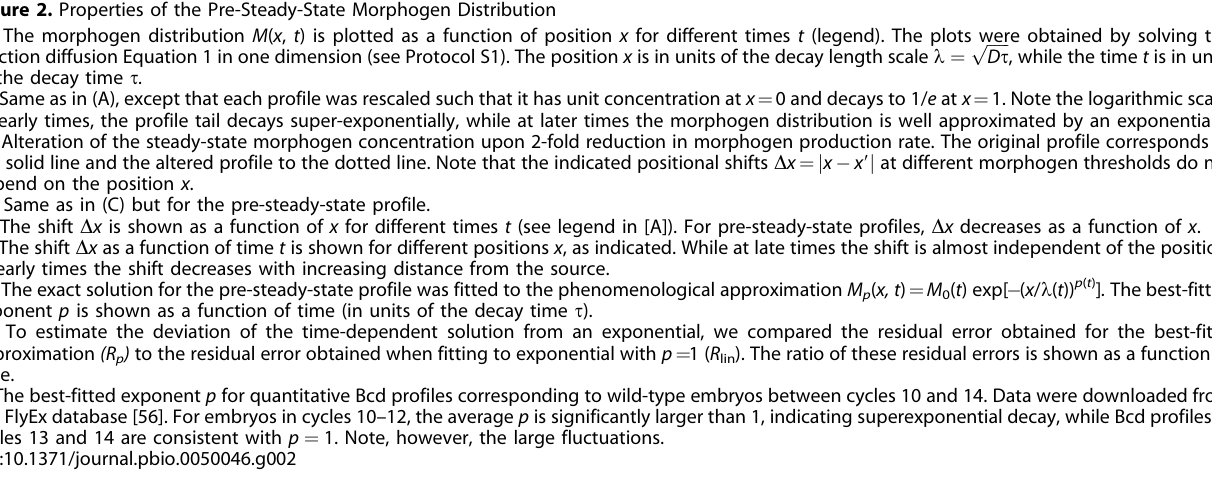
p , while the time t is in units